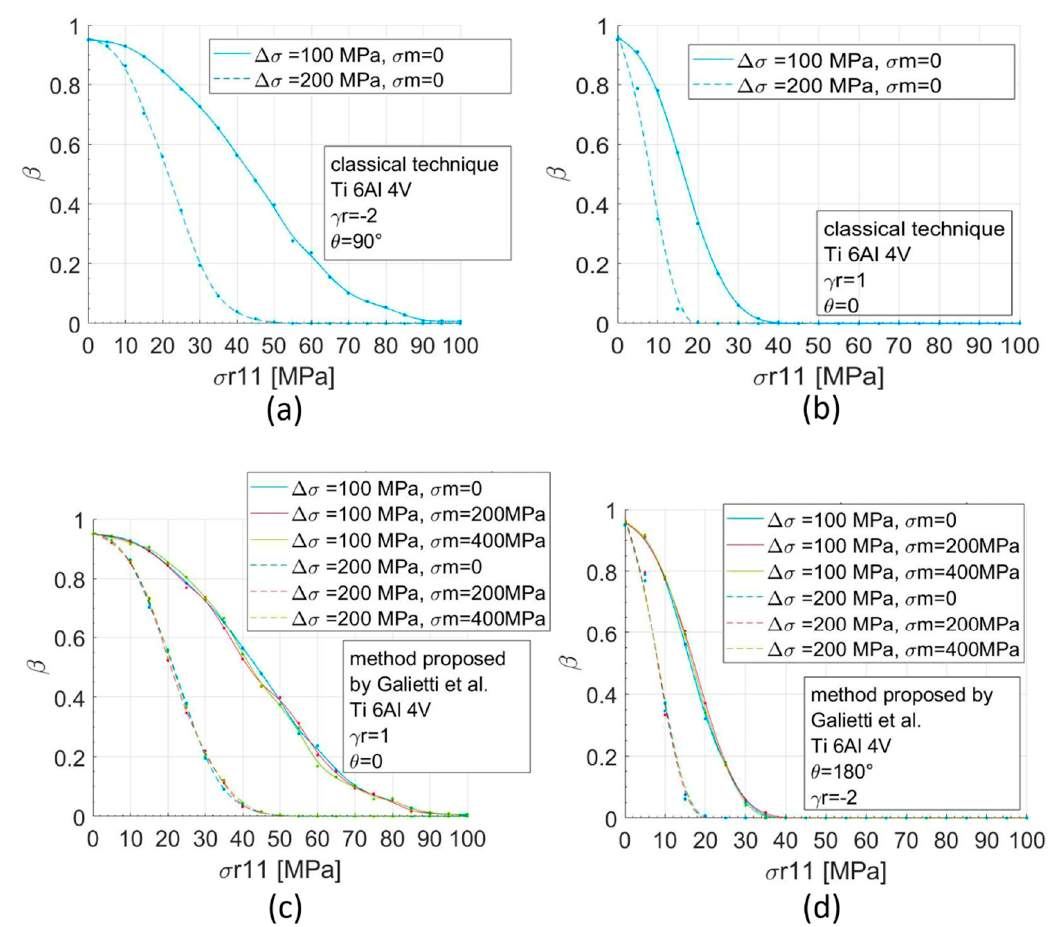
Figure 9. Second type error as function of σ r 11 for the Ti6Al4V alloy: The classical technique and the method proposed in Reference [17] are compered for the case of ( a , c ) for low and ( b , d ) for high residual stresses effect .